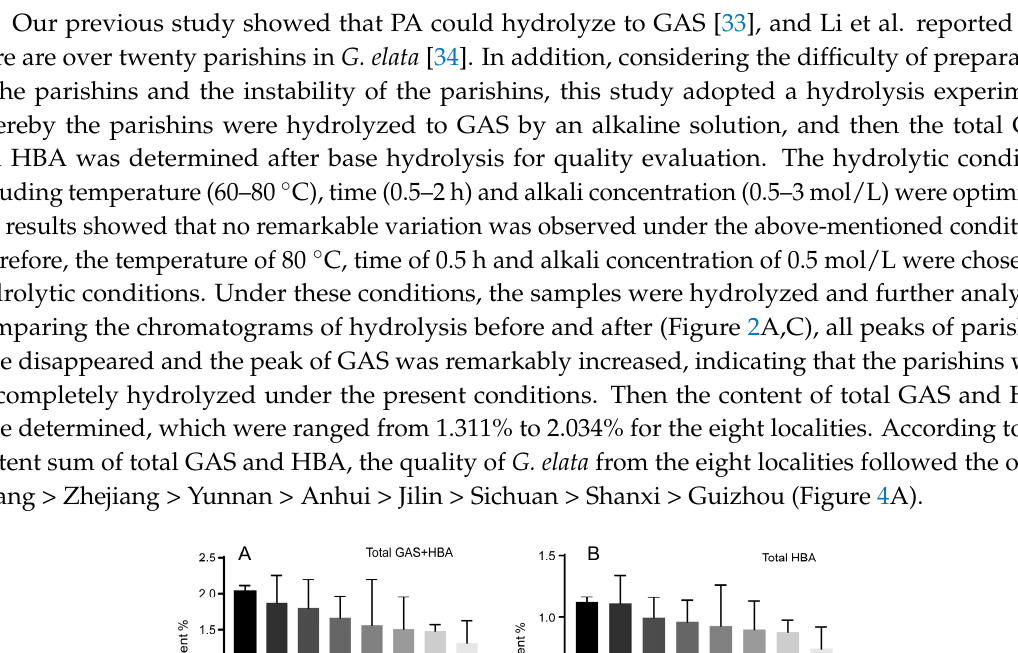
Figure 3. Biplot of the average content of GAS, HBA, PE, PB, PC and PA with eight localities of G. elata .